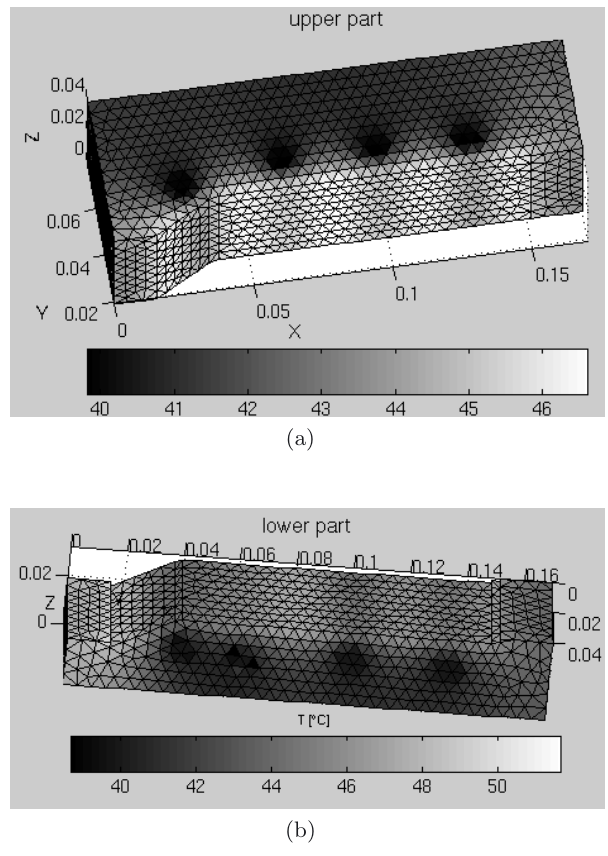
Fig. 10. Temperature at the surface of the 3D mold after optimization.